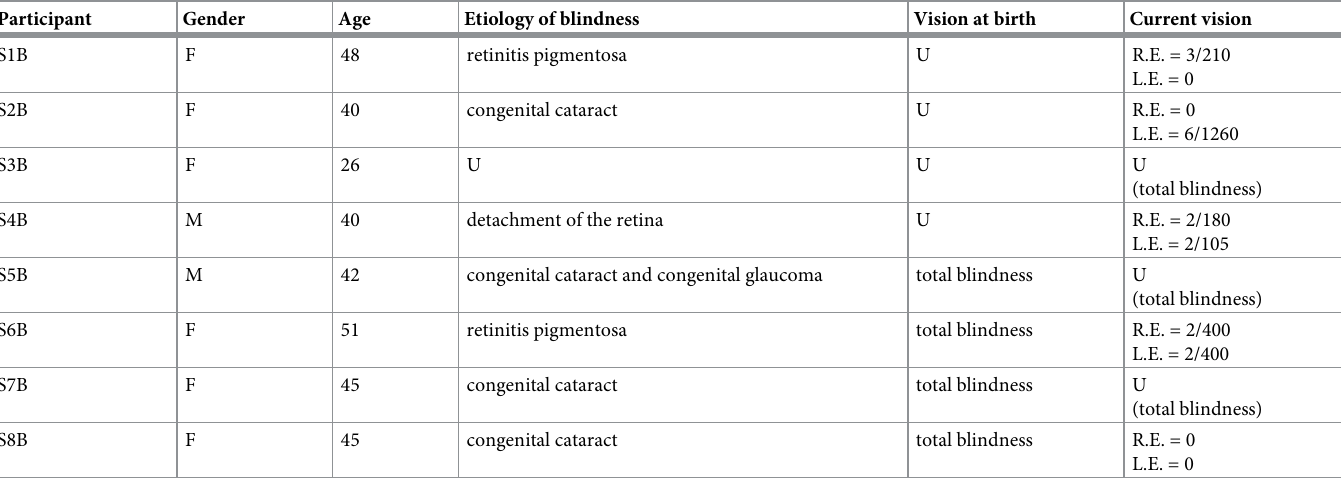
Table 2. Characteristics of the eight blind speakers.